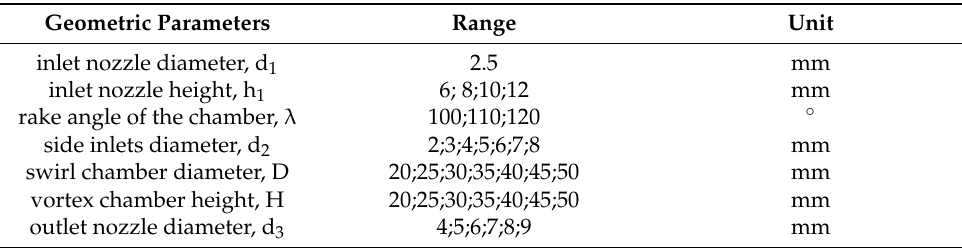
Table 1. Ranges of the variability of the investigated geometric parameters for various design solutions of a self-excited pulse head operating at a pressure of 150 MPa.